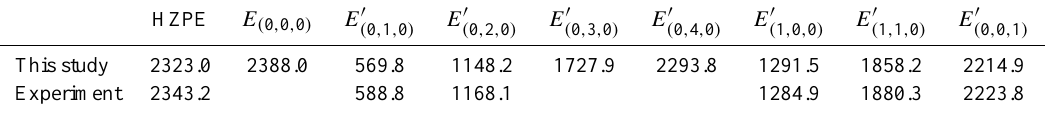
= E i − E ( 0 , 0 , 0 ) . The experimental excitation energies are the gas phase i + E 0 + 0 . 5 E 0 is a harmonic estimate of the zero point ( 1 , 0 , 0 ) ( 0 , 1 , 0 ) ( 0 , 0 , 1 )